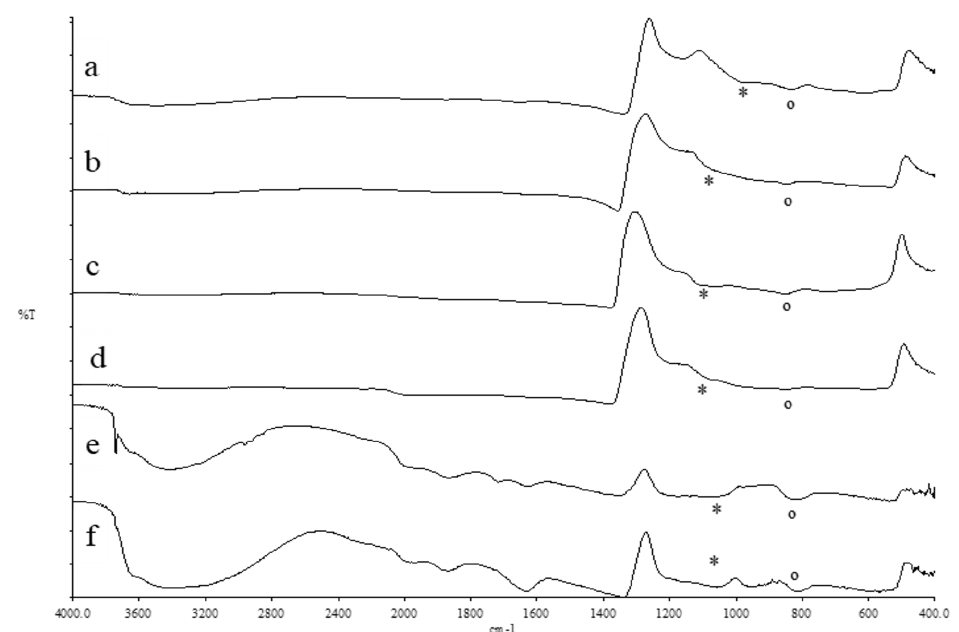
Figure 1. DRIFT / MIR spectra of silica samples of different D (50) (µm), measured by Fraunhofer. Marked bands: 850 cm-1 (0) and 1060 cm-1 (*): a) MSS 500 (3.28); b) Chiffonsil-5 (4.87); c) Oristar Silica 7 (5.93); d) Silica Balloon BA4 (6.13); e) Silica HDK N20 (16.46); f) Silica Sicosil 175 (67.8). The displacement (distortion) of the band at 1060 cm-1 may be due to specular